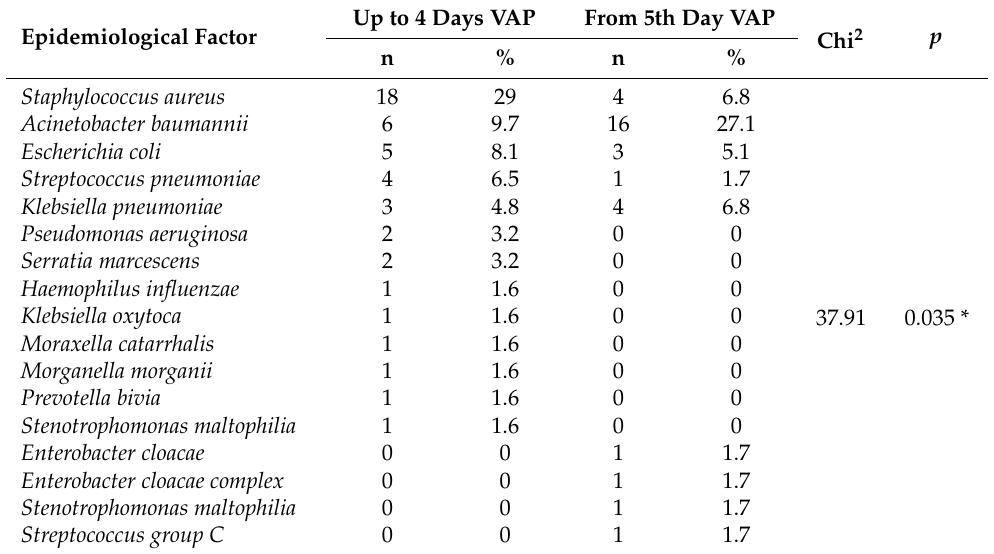
Table 9. The correlation between epidemiological factor VAP contraction time. Epidemiological